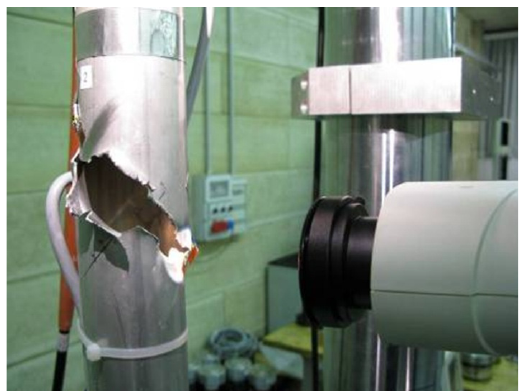
Figura 11: Fotografia di un albero danneggiato dopo l’impatto balistico.